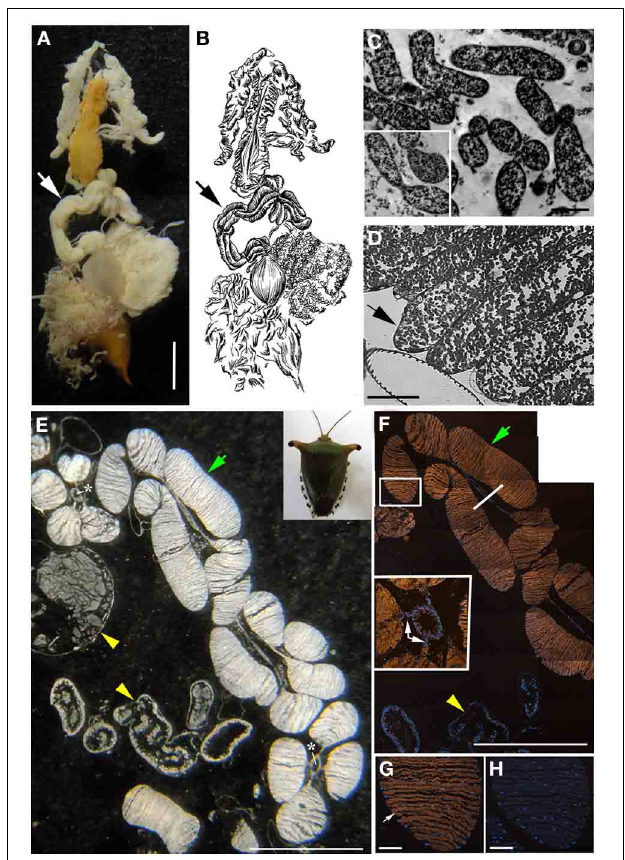
FIGURE 3 | Bacteria associated with Edessa n. sp. 1 (A) Dissected digestive system, arrows indicate symbiont-bearing tissue. Scale, 2mm (B) Line drawing of the digestive system (C) Transmission electron microscopy of rod-shaped bacteria-like cells within the midgut ceca. Scale, 2 µ m. Inset shows bacteria dividing (D) Light microscopy showing bacteria-containing crypts within the midgut ceca (arrow). Scale, 20 µ m. (E) A longitudinal section through the midgut ceca. The arrow denotes symbiont-containing midgut crypts, and the arrowheads are provided for reference to the non-symbiont containing tissues, including the upper left sac-like midgut region (M3) and the lower region of the hindgut, as denoted in Futahashi et al. (2013). Asterisks show the main gut cavity. Scale, 2mm (F) Fluorescence in situ hybridization (FISH) microscopy of the same region as shown in E, hybridized with the Gam42 probe (Manz et al., 1992) labeled with Cy3, shown in orange, and counter-stained with DAPI, shown in blue. The square denotes the region shown in G/H. Scale, 2mm. The line shows the location of the tissue in the inset in cross section. Inset shows connections between main gut cavity and crypts (arrows). (G) FISH microscopy of the region denoted in F, using the Edessa -symbiont specific probe labeled with Cy3, shown in orange, and counter-stained with DAPI, shown in blue. Scale, 100 µ m. (H) FISH microscopy of the region denoted in F, as a negative control using an Epsilonproteobacteria-specific probe (EP404, Macalady et al., 2006), labeled with Cy3, shown in orange, and counter-stained with DAPI, shown in blue. Scale, 100 µ m.